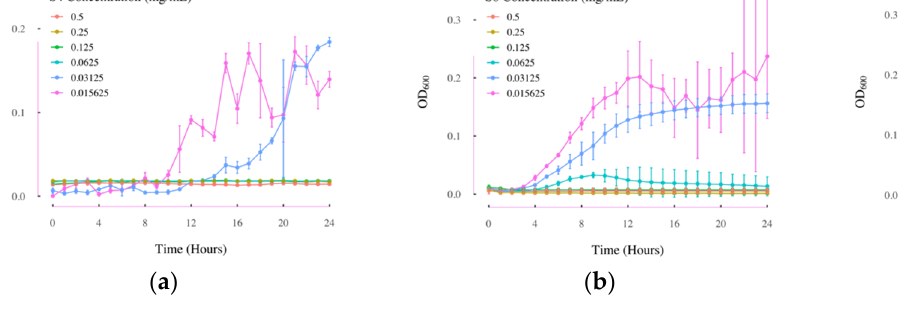
Figure 5. The growth curves of E. coli over 24 h in MIC test. ( a ) Growth curves of E. coli under different concentrations of compound C4 treatment over 24 h; ( b ) growth curves of E. coli under different concentrations of compound S8 treatment over 24 h; ( c ) growth curves of E. coli under different concentrations of compound S17 treatment over 24 h. S4: albendazole; S8: diflunisal; S17: 2-amino-5-bromobenzimidazole; OD 600 : the absorbance at 600nm; n = 3. Error bars represent standard deviations.